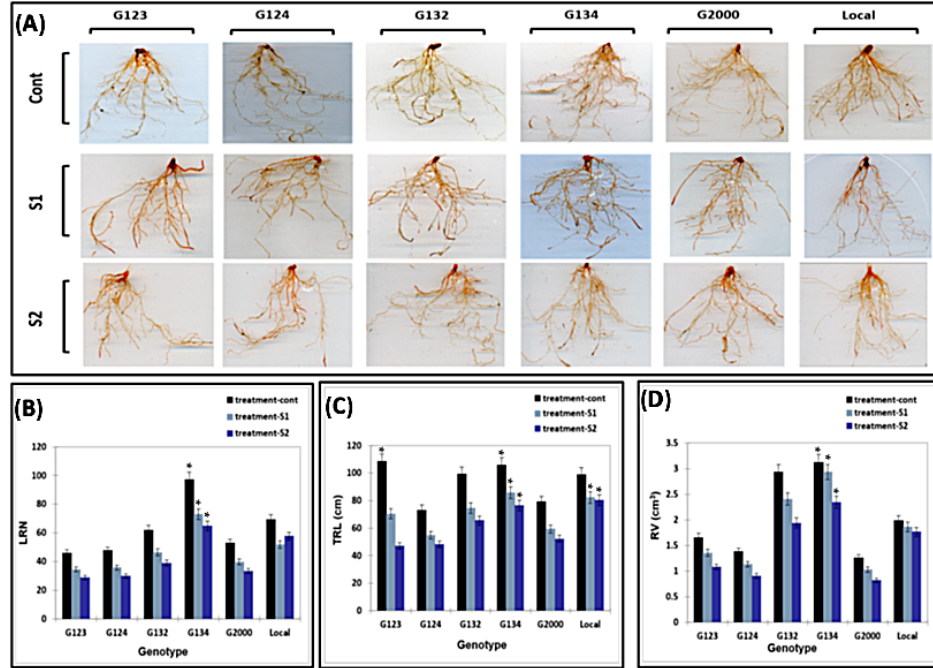
Figure 4. Selected stained root for photo scanning and analyzing of control and salinity levels of all genotypes, respectively ( A ). Effect of different salinity levels on the RSA of six barley genotypes ( B – D ). The 8-day-old barley seedlings that were grown in the magenta box and stained with toluidine red. Means significant difference between the genotypes at probability level of 0.05.